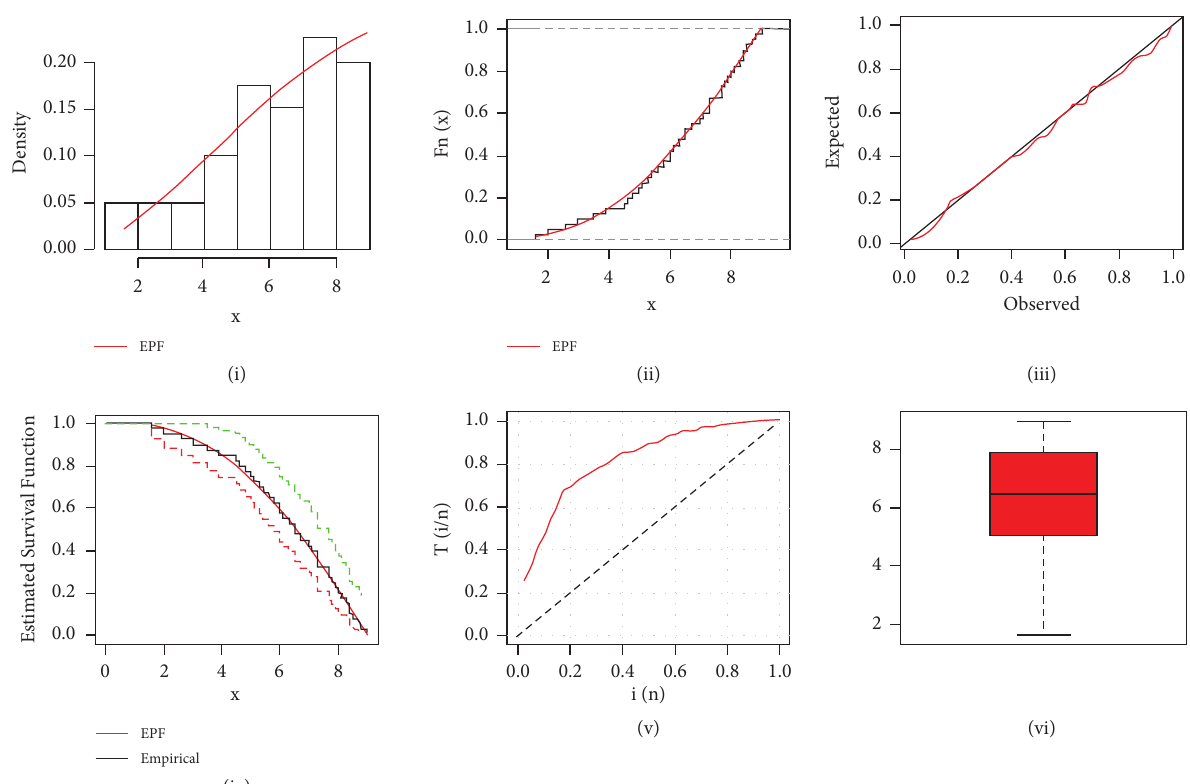
Figure 4: Fitted density (i), estimated CDF (ii), PP plot (iii), Kaplan–Meier survival (iv), TTT plot (v), and box plot (vi) for turbocharger